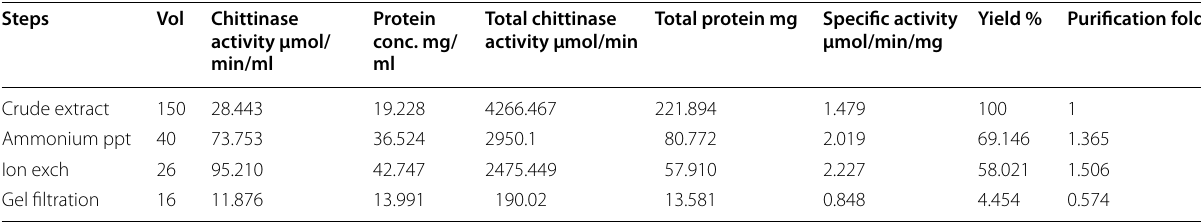
Table 5 Purification steps of crude chitinase produced from Streptomyces albus Steps